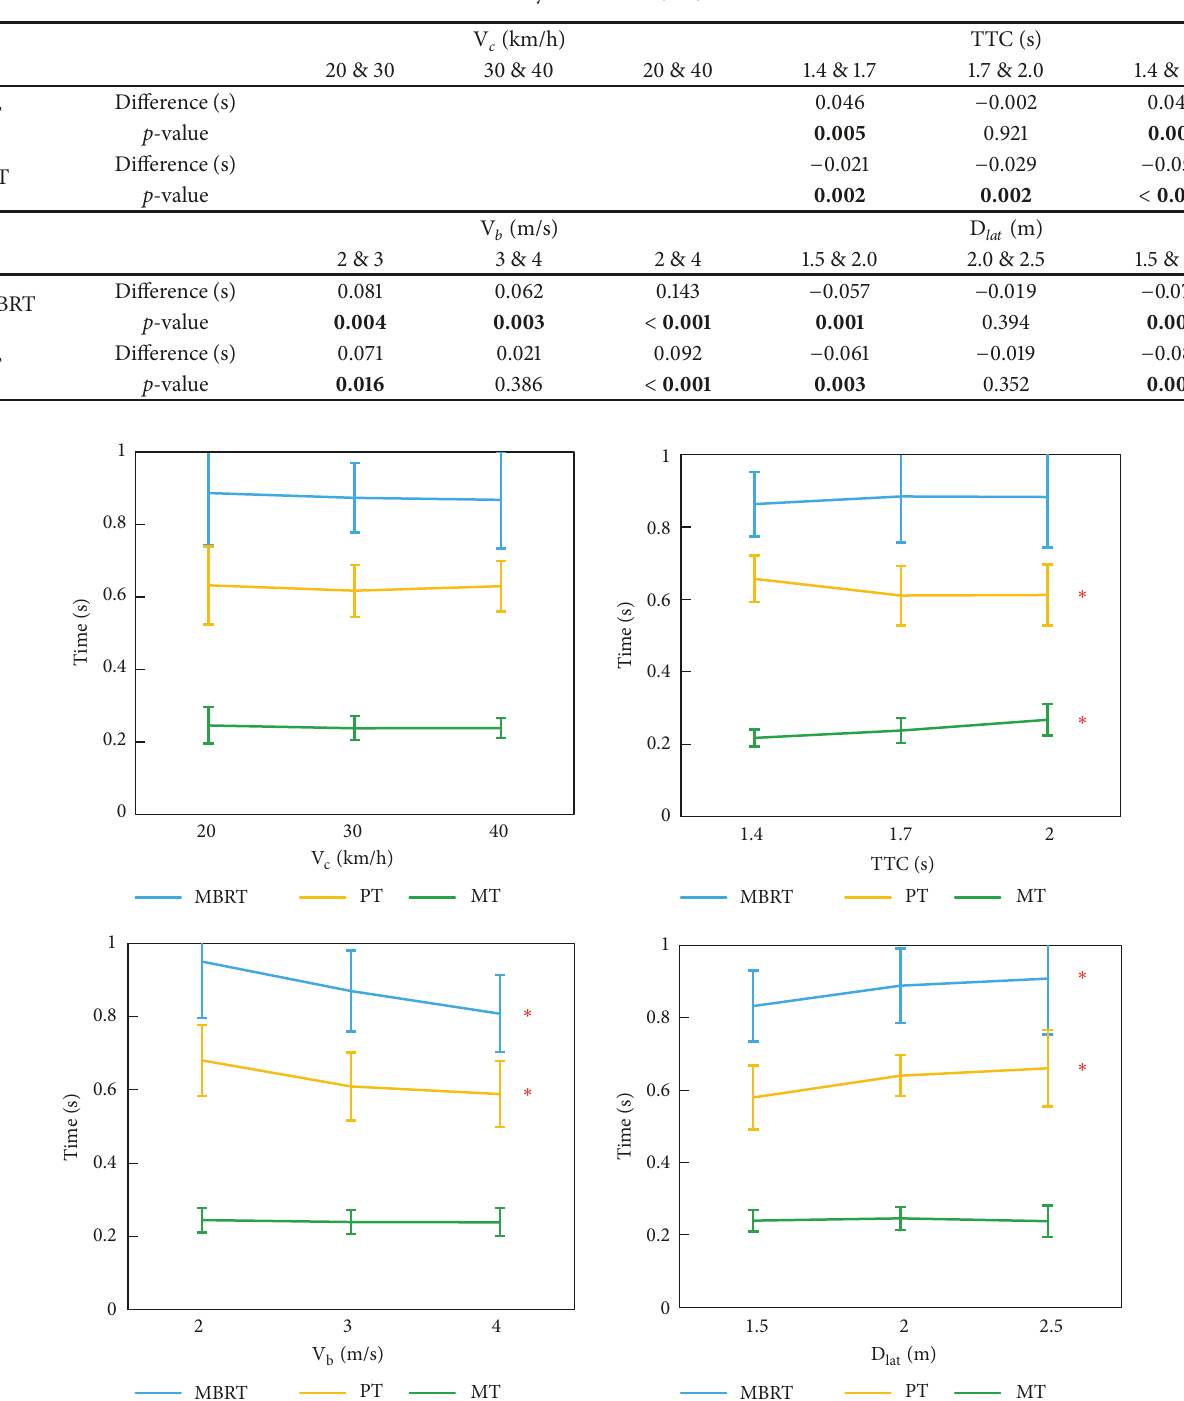
Table 4: Post hoc analysis for MBRT, PT, and MT in SCR.